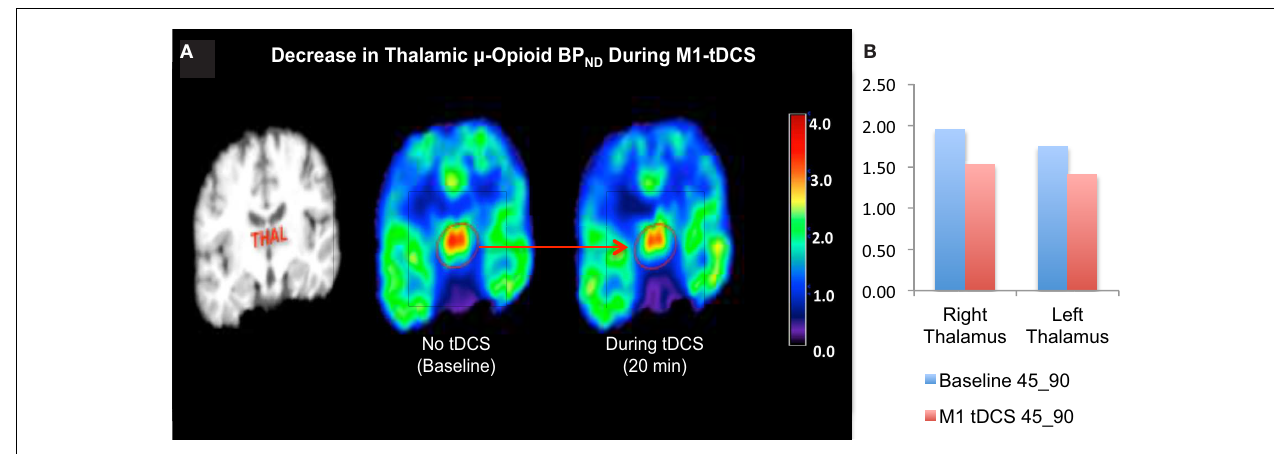
FIGURE 2 | (A) Decreased thalamic µ -opioid receptor availability during active tDCS, represented in the coronal plane. (B) Bar chart illustrating the µ -opioid receptor binding potential in the right and left thalamus during the late phase of the first and second PET scans.